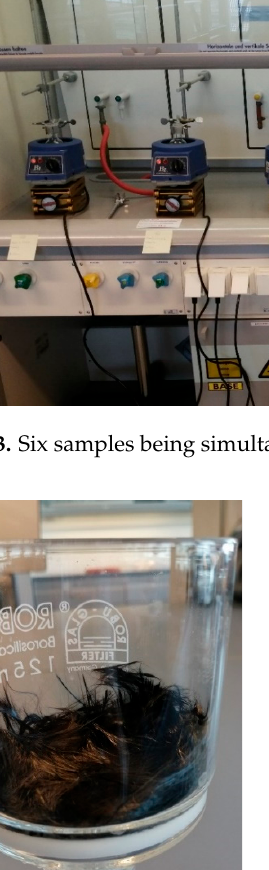
Figure 4. Remaining carbon fibers in the filter after the etching process.